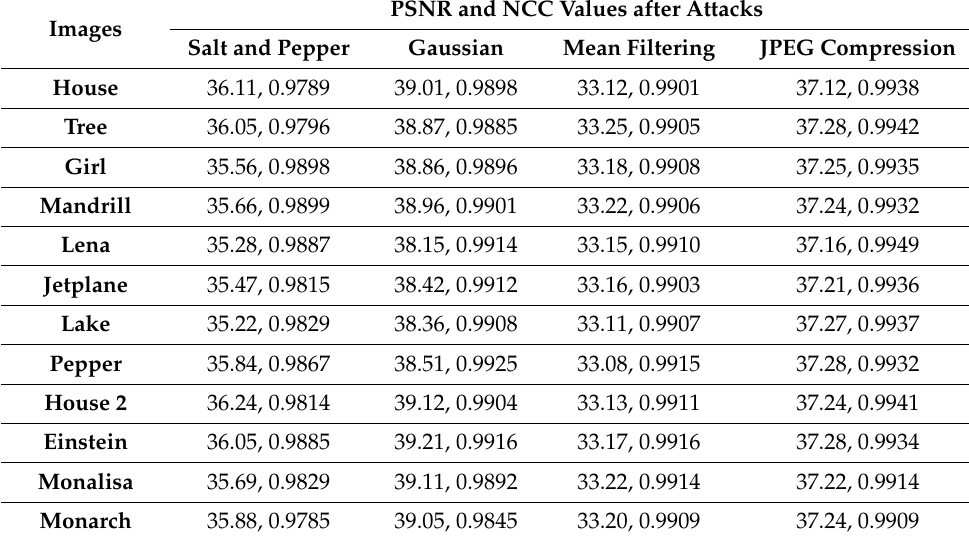
Table 3. PSNR and NCC values with different attacks.